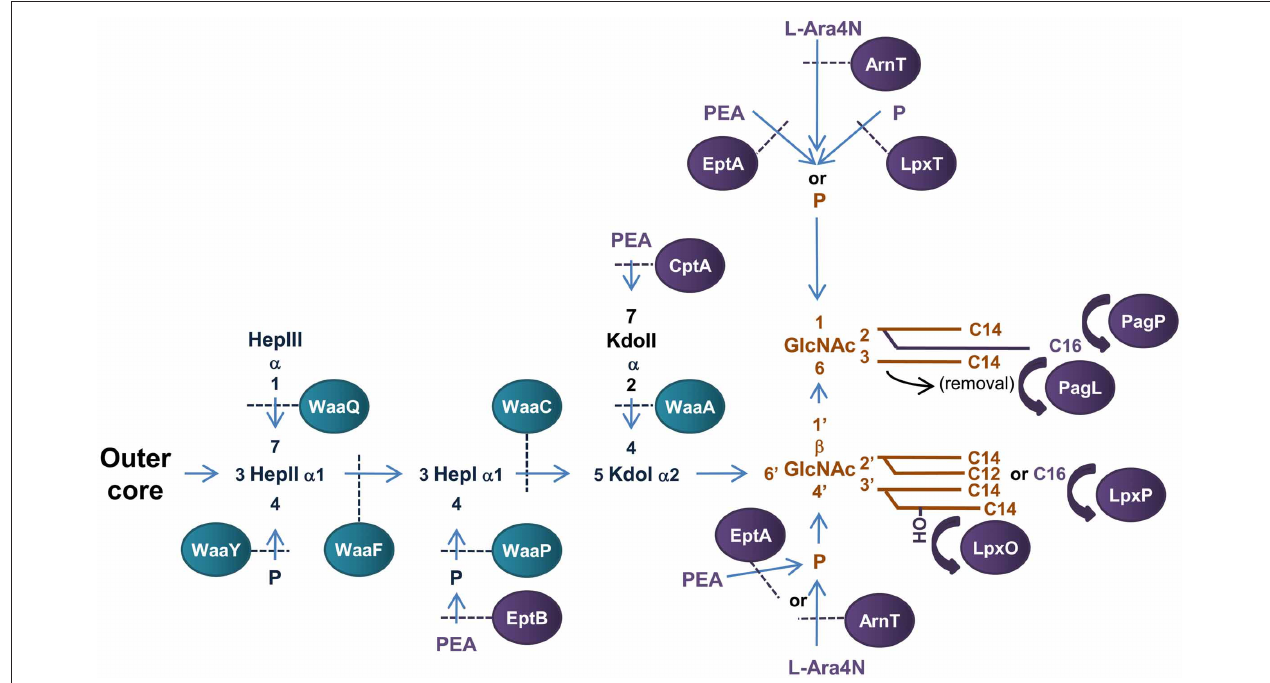
FIGURE 3 | Structure and biosynthesis of E. coli LPS. The conserved Lipid A region is in orange while the conserved inner OS core region is in dark blue and variable modifications to these regions are in purple. Glycosyltransferases that form the inner OS core backbone are denoted by the blue boxes, and